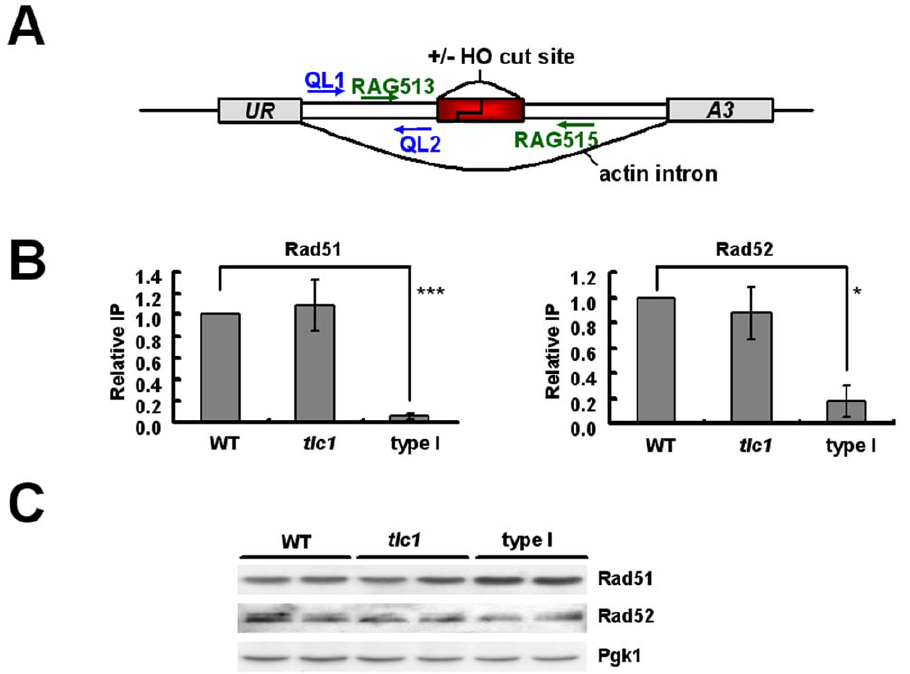
Figure 4. Recruitments of Rad51 and Rad52 at an HO cut site are reduced in type I survivors. ( A ) The structure of the URA3 allele on S. cerevisiae chromosome V for these experiments. The position of various oligonucleotide primers (arrows) used for PCR and real-time PCR are shown. ( B ) ChIPs were performed and quantitated by real-time PCR as described in Materials and Methods. Error bars represent standard deviations for at least three independent experiments and are provided for these strains. Bindings of Rad51 and Rad52 to HOcs in type I cells differed from those in wild-type in a statistically significant manner ( P values =0.0002 and 0.0115, respectively). These differences were not observed when a mock immunoprecipitation was performed with normal rabbit IgG (data not shown). ( C ) Rad51 and Rad52 expression levels in these strains were analyzed by Western blot analysis.